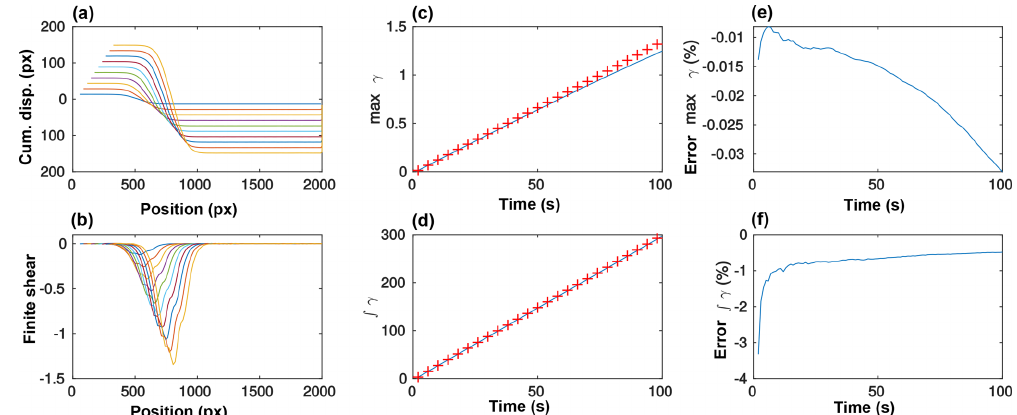
Figure 9. Benchmark of the Lagrangian sum of displacements. (a) Cumulative displacement profiles across the moving shear zone (profile plotted every 10 frames only for clarity); (b) gradients of the cumulative displacement profiles from panel (a) ; (c) evolution of the peak of the gradient of the cumulative displacements (i.e. max shear, γ ) versus time (assuming 1s between frames in synthetic tests) measured from PIV (red crosses) versus the solution (blue line) every four frames; (d) integral of the shear profile versus time measured from PIV (red crosses) and solution (blue line) every four frames; (e) error on the peak cumulative shear strain; (f) error on the integrated cumulative shear strain.